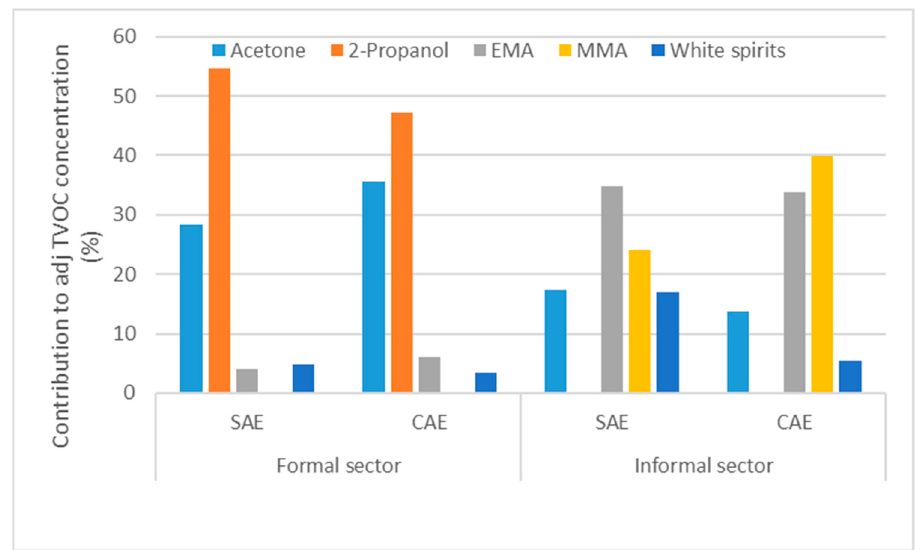
Figure 1. Major contributors to the adjusted TVOC-concentration (%) for both sectors and assessment regimes: SAE: self-assessment of exposure, CAE: controlled assessment of exposure. EMA: ethyl-methacrylate; MMA: methyl-methacrylate.